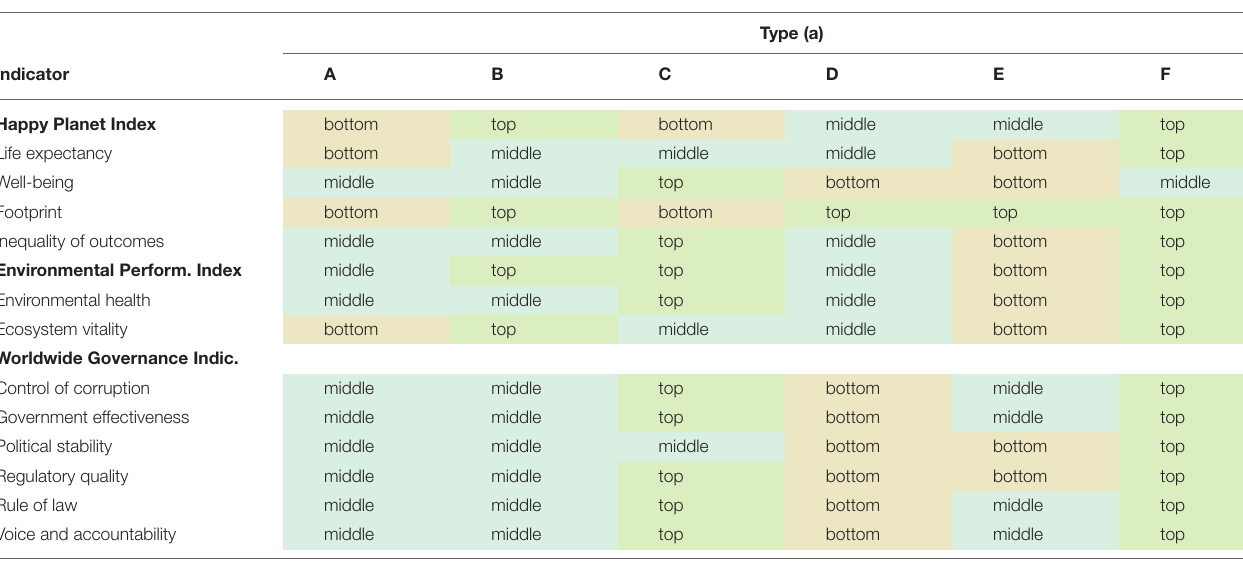
TABLE 5 | Country-level indicators for the city